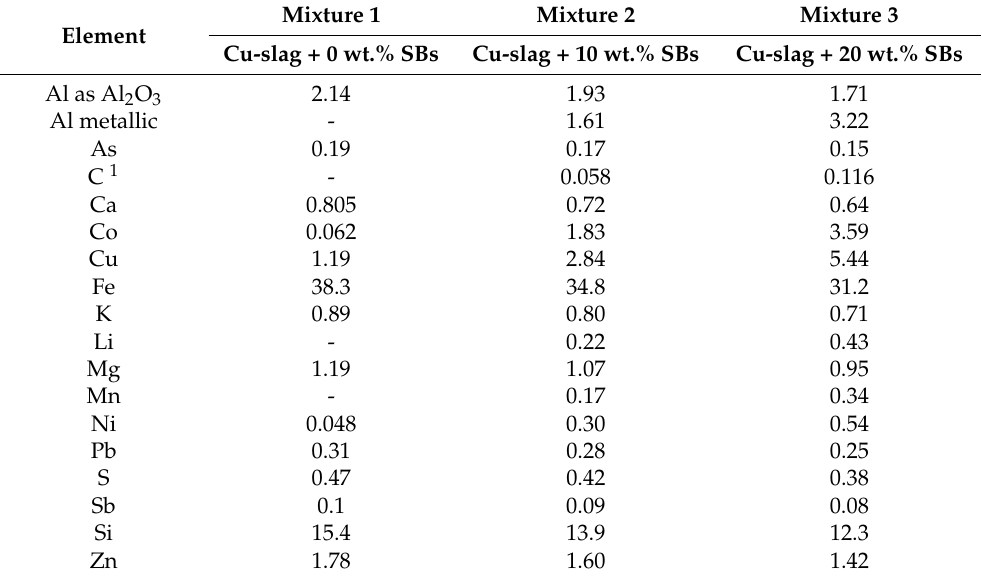
Table 6. Chemical composition of the starting mixtures utilized in pyrometallurgical experiments. Mixture 1 Mixture 2 Mixture 3 Element Cu-slag + 0 wt.% SBs Cu-slag + 10 wt.% SBs Cu-slag + 20 wt.%